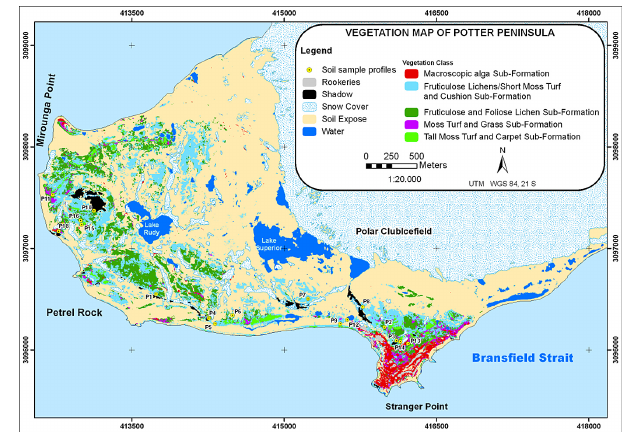
Figure 3. Vegetation map of Potter Peninsula, maritime